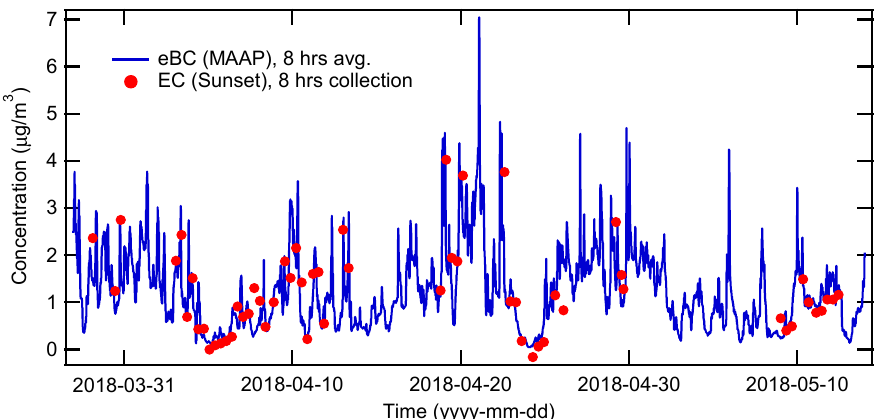
Figure 3. Time series of comparison plot between EC and eBC concentrations.